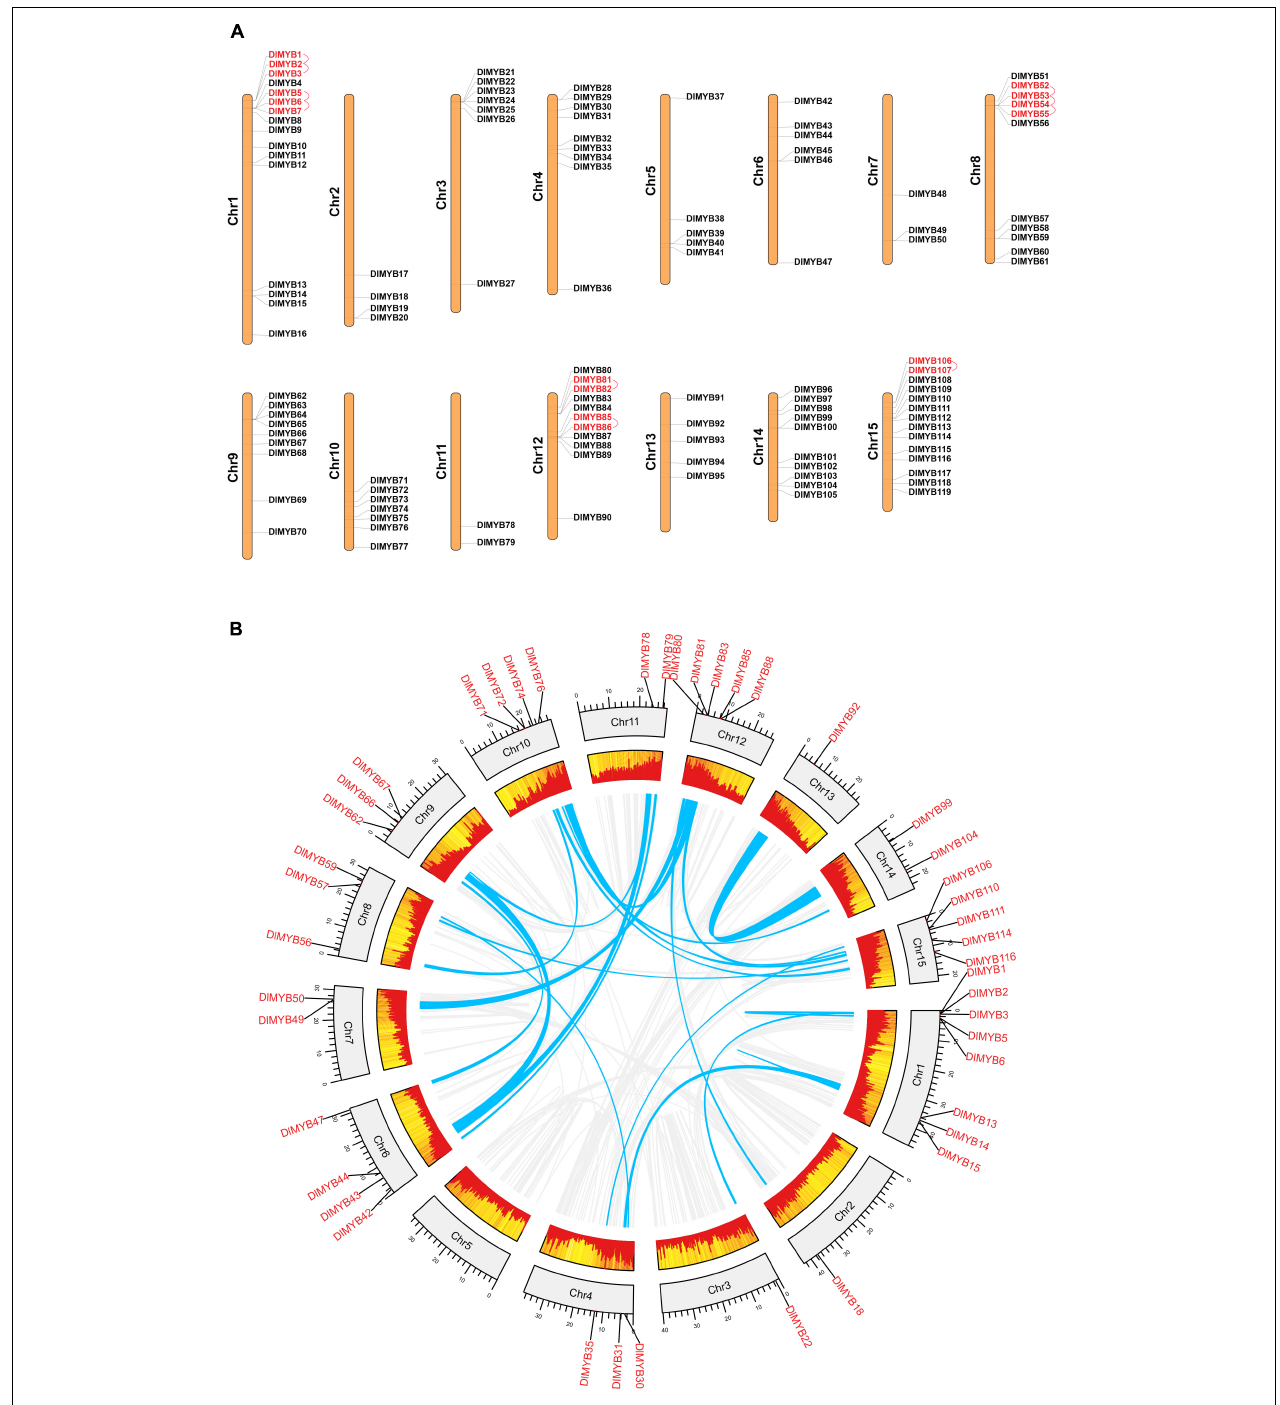
FIGURE 4 | Chromosomal location, tandem duplication, and segmental gene duplication analysis of the DlMYB genes. (A) The distribution map of DlMYB genes on the 15 chromosomes of longan (genes with tandem clusters are marked in red). (B) Circos plot of DlMYB genes in the longan genome. Gene pairs with segmental duplications (SDs) are indicated by blue lines, and gene density was highlighted by red rectangular boxes.